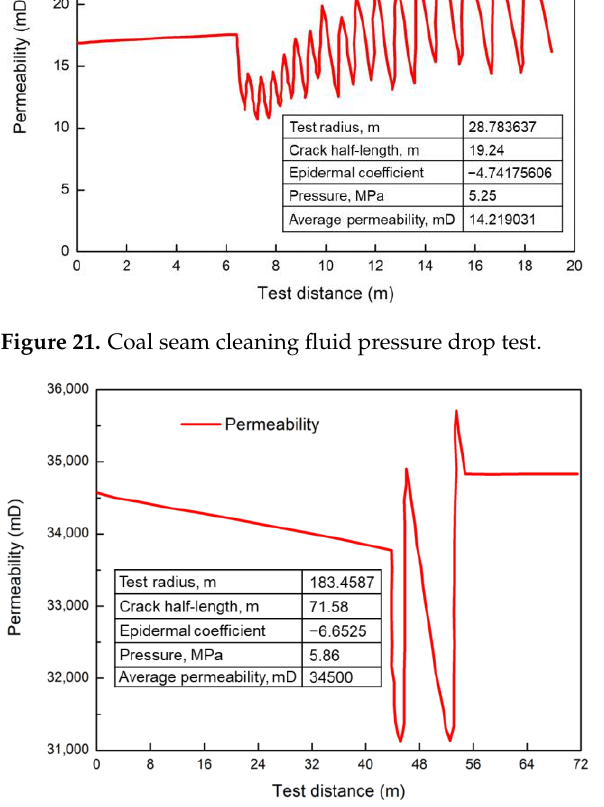
Figure 22. Dynamic fracturing crack pressure drop testing of graphene–foam–cement slurry fracturing.